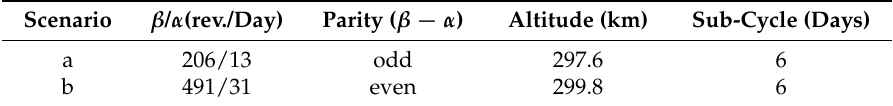
Table 2. Selected scenarios for detailed comparisons.